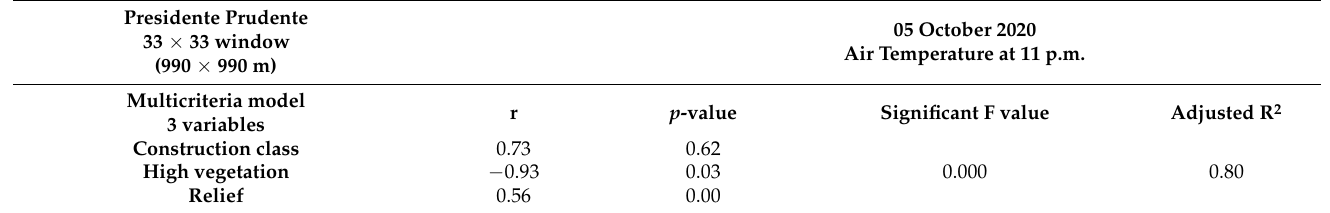
Table 1. Results of data validation of the spatial model considering simple and multiple linear re- gression and significance tests with p -value ( α ≤ 0.05), as performed by ANOVA in Presidente Pru- dente, Brazil.